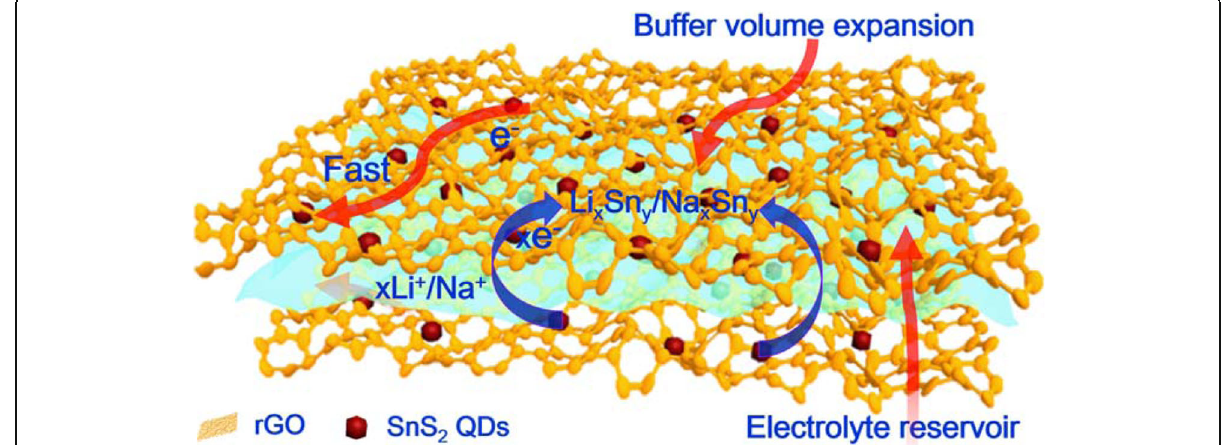
Fig. 5 Schematic illustration highlights the structural benefits of the 3D SnS 2 QDs/rGO composite during the charge/discharge